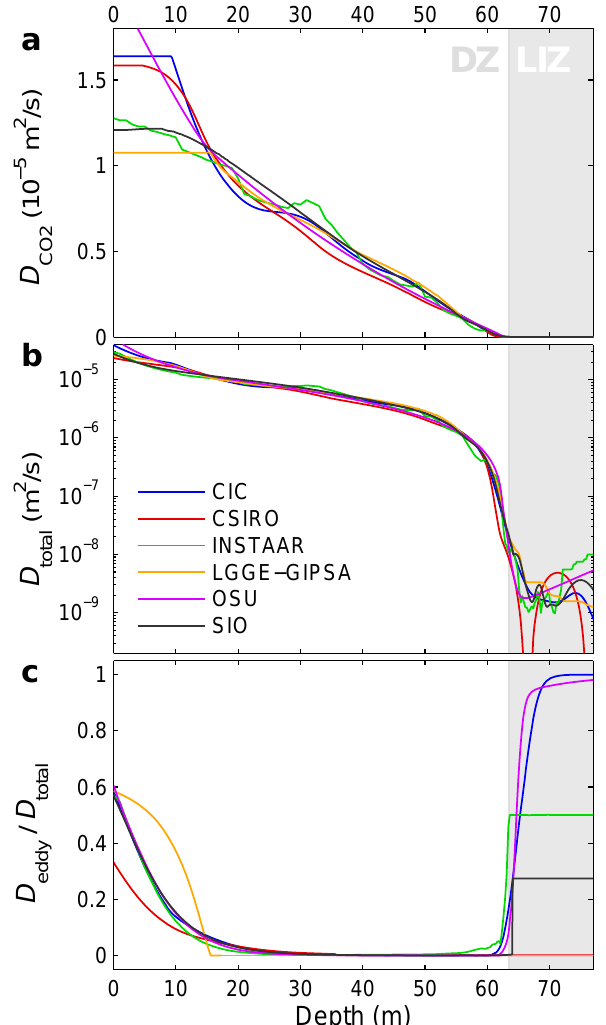
(z) for Fig. 5. (a) CO 2 molecular diffusivity profile with depth D CO 2 the EU borehole. (b) Semi-log plot of the total CO 2 diffusivity pro- (z) + D eddy . (c) Plot of D eddy (z)/D total (z) . file D total (z) = D CO 2 Eddy diffusion near the surface corresponds to convective mix- ing; in the LIZ some of the models include dispersive mixing. The CSIRO model has zero eddy diffusivity in the LIZ; the line is not visible as the LGGE-GIPSA model is plotted on top of it.